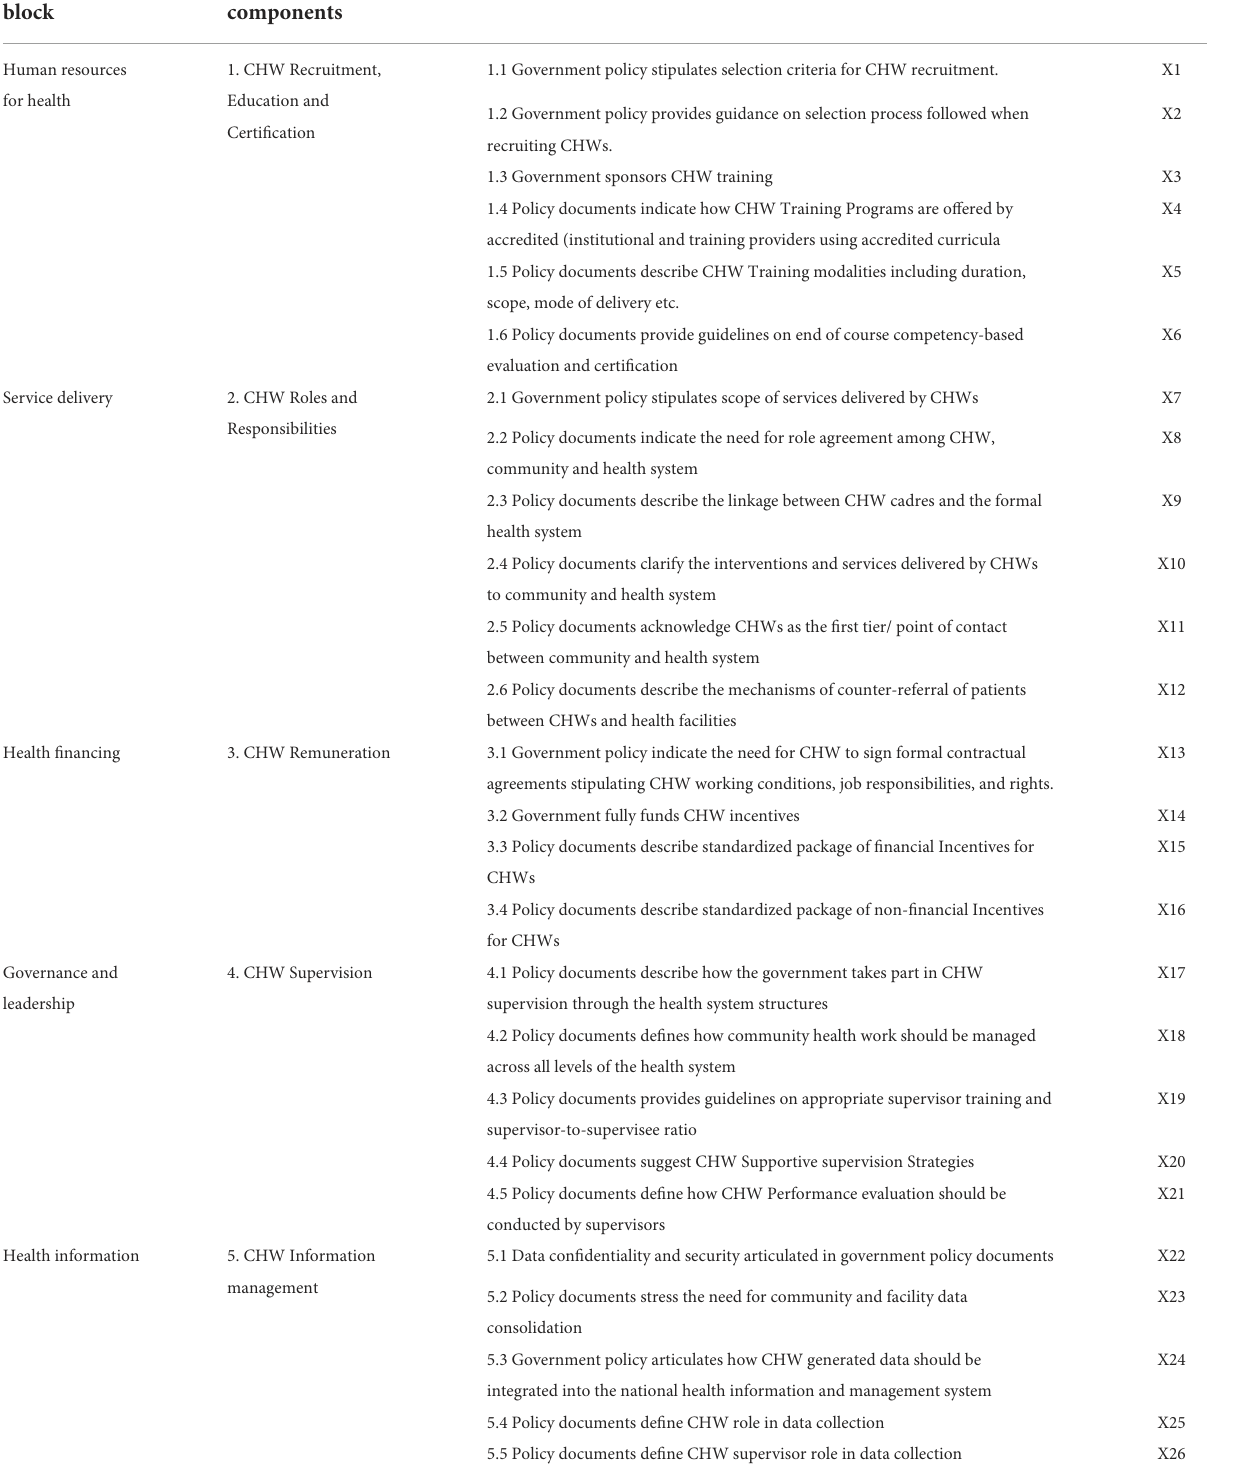
TABLE 1 The six WHO critical functions and community health worker (CHW) integration program components, integration parameters, and integration indicators (measures). Who